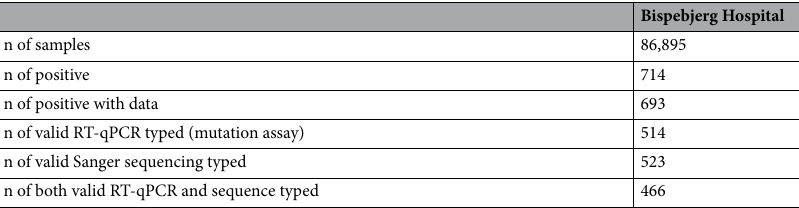
Table 7. 714 positive samples were found at Bispebjerg hospital, 693 of the samples were analyzed using RT-qPCR melting curve assay and Sanger sequencing. 466 of the samples could be analyzed with both methods.